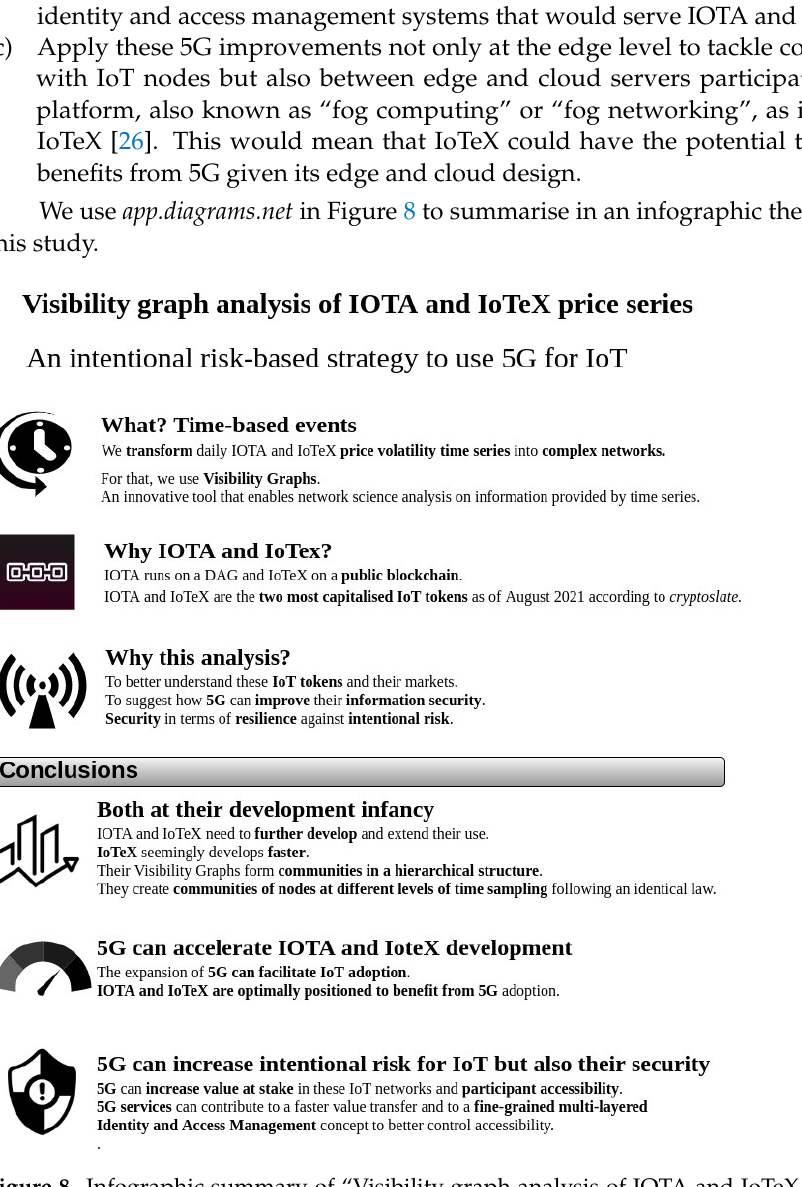
Figure 8. Infographic summary of “Visibility graph analysis of IOTA and IoTeX price series: An intentional risk-based strategy to use 5G for